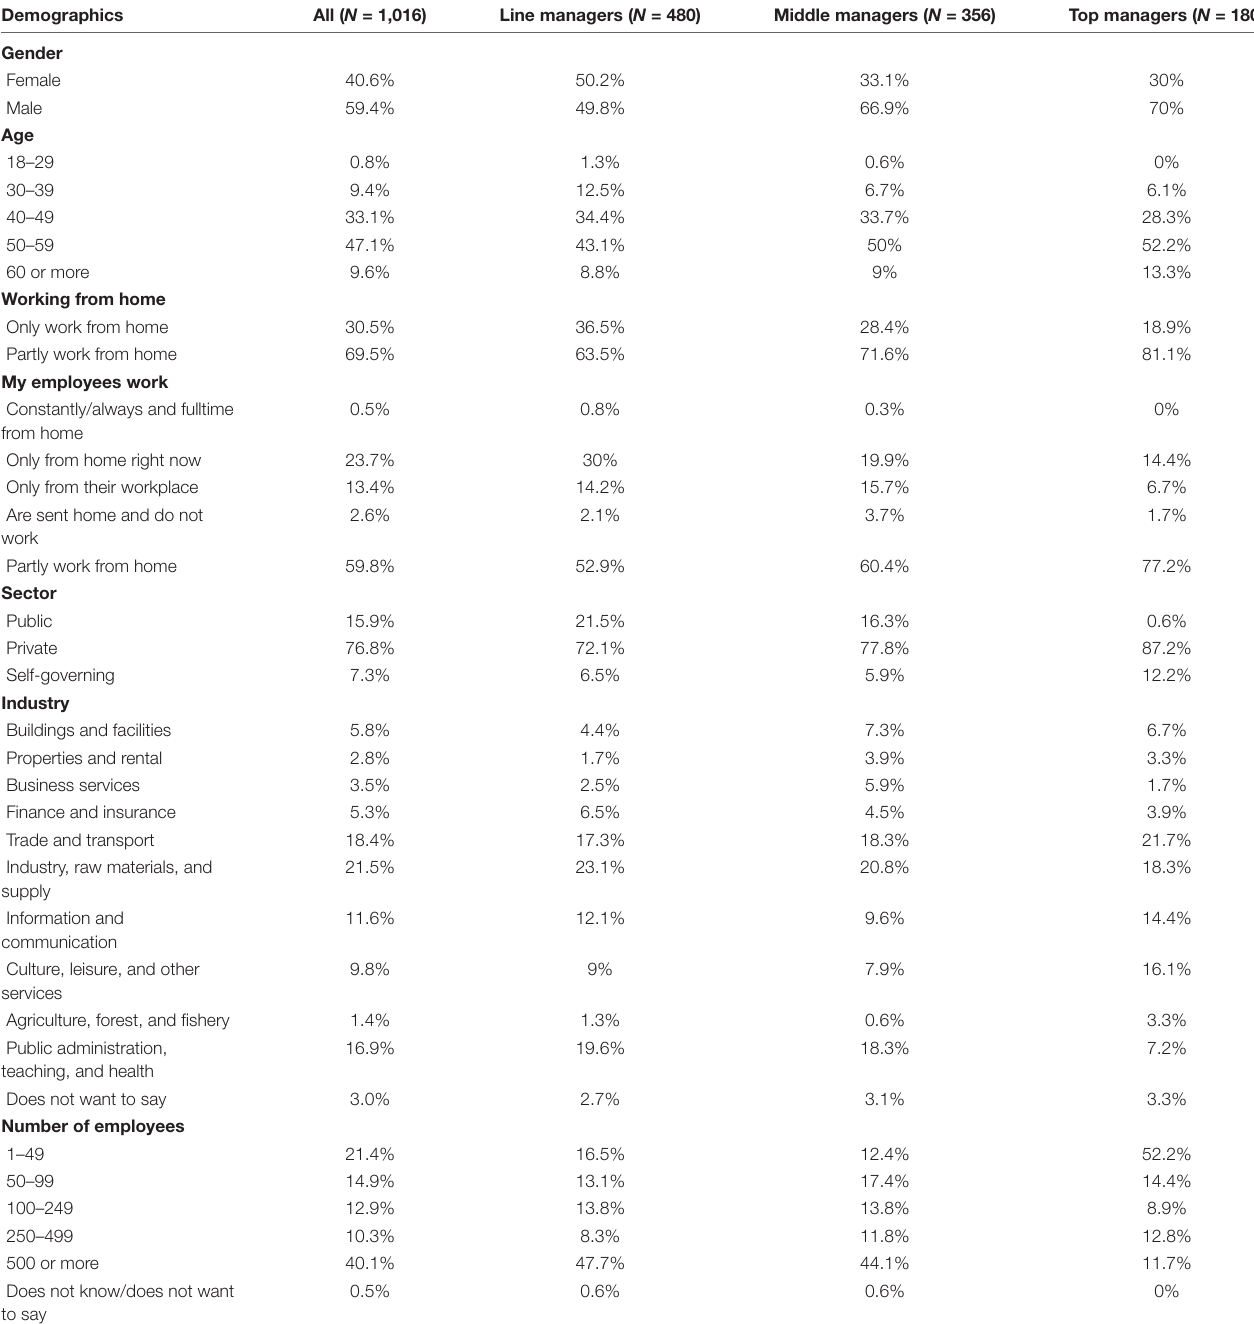
TABLE 1 | Characteristics of the investigated